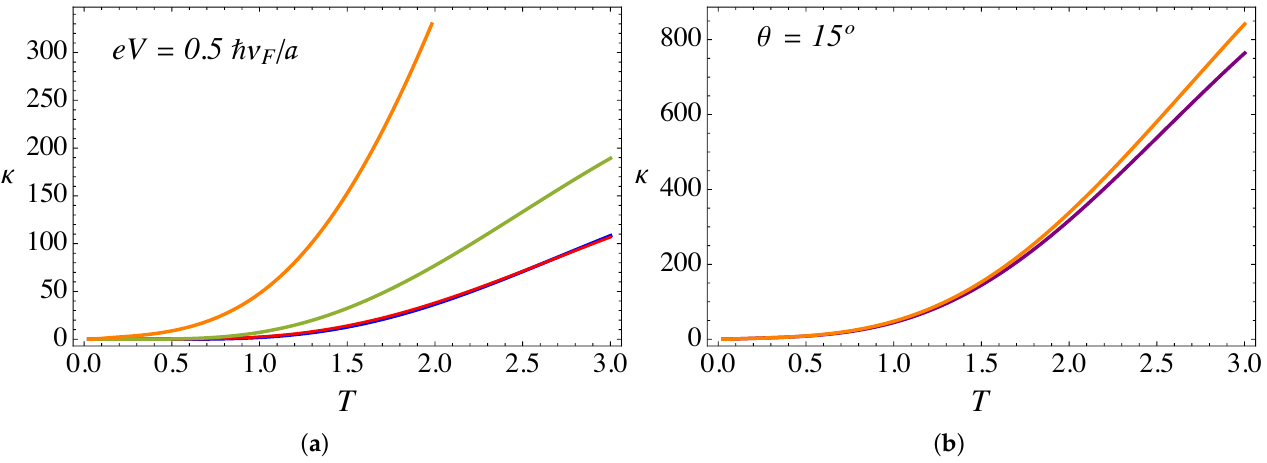
Figure 10. (Color online) ( a ) Thermal conductance (in units of k B v F / a ) as a function of temperature (in units of ¯ hv F / k B a ), computed from the analytical expression in Equation (16), for external B 0 a 2 = 25 ˜ φ 0 , a bias eV = 0.5 ¯ hv F / a , and α = 3 π /4. The blue line corresponds to θ = 0 ◦ , red is for θ = 5 ◦ , green is for θ = 10 ◦ , and the orange line corresponds to θ = 15 ◦ . ( b ) Comparison of the thermal conductance for θ = 15 ◦ : the purple line is for α = 0 whereas the orange line is for α = 3 π